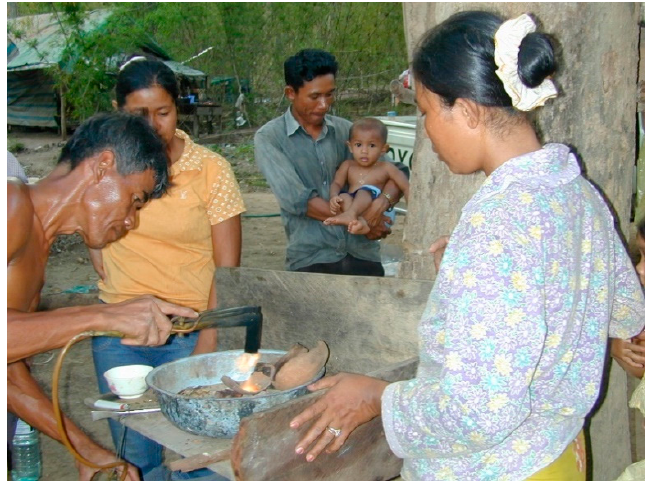
Figure 6. Miner separating mercury from gold (T.